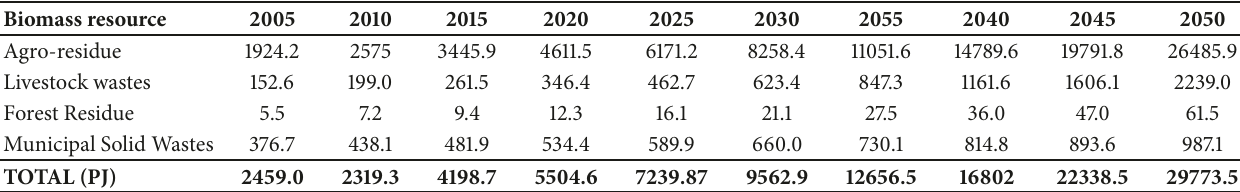
Table 7: Total biomass energy potential in